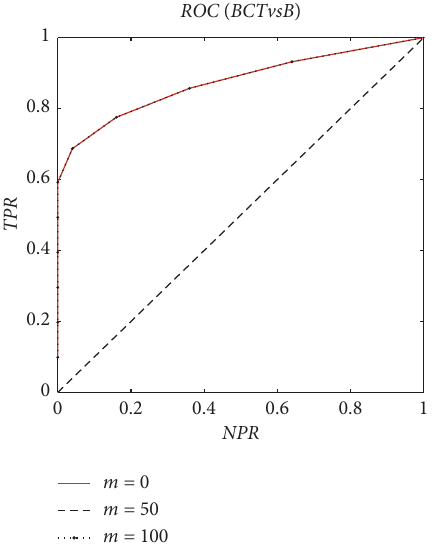
Figure 3: Te ROC curve comparing model BCT and B .